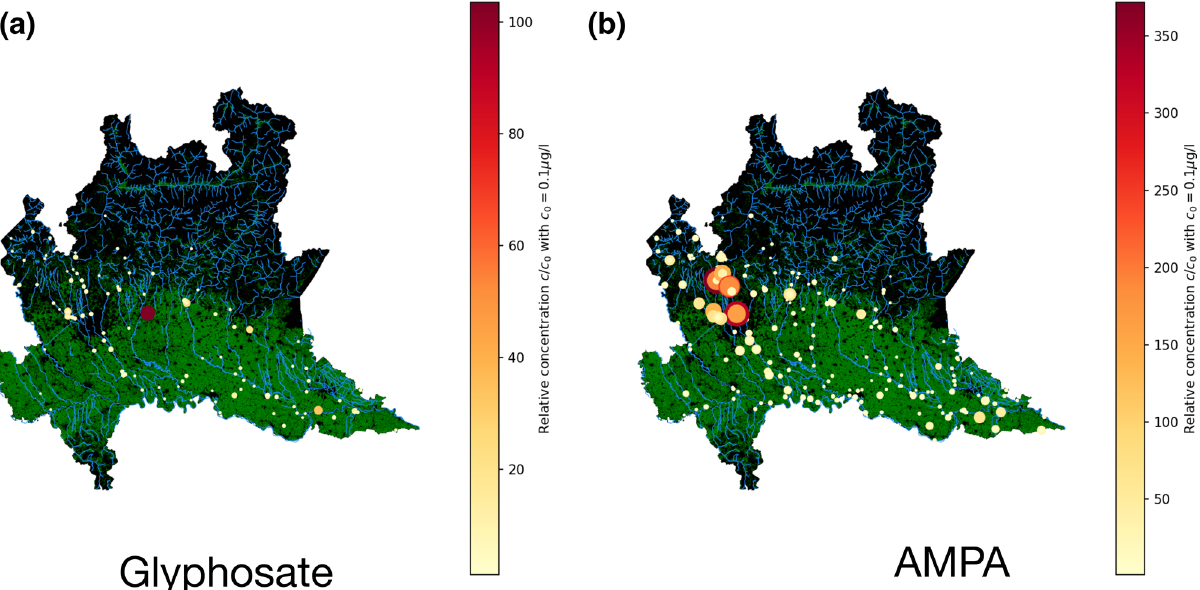
Figure 2. Glyphosate and AMPA in surface waters. Relative concentration of ( a ) glyphosate and ( b ) AMPA. We only report data when c > 0.1 μg/l. Colorbar and marker size both indicate the relative concentration. Cultivated areas are colored in green and rivers in cyan. The map was created in python3.7 using the geopandas (0.6.1) package (https:// geopa ndas.